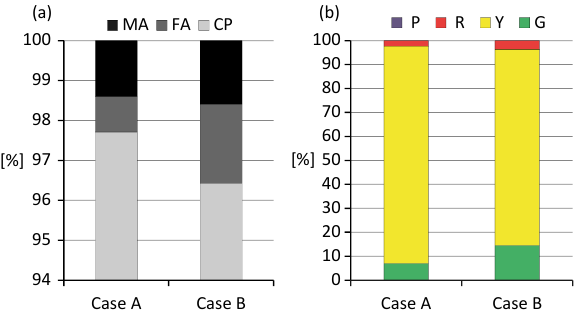
Figure 6. Duration matrix results in terms of criterion 1 (a) and criterion 2 (b) .